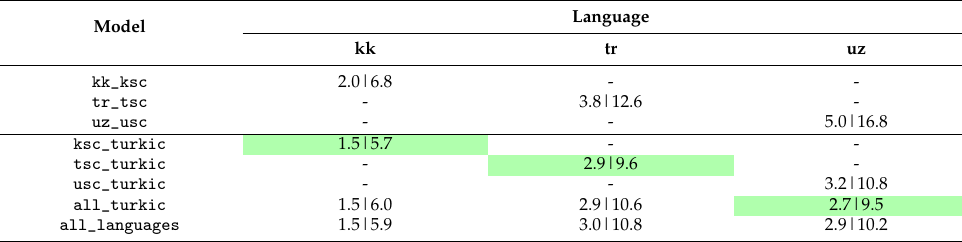
Table 7. The CER (%)| WER (%) results of eight models on the KSC, TSC, and USC test